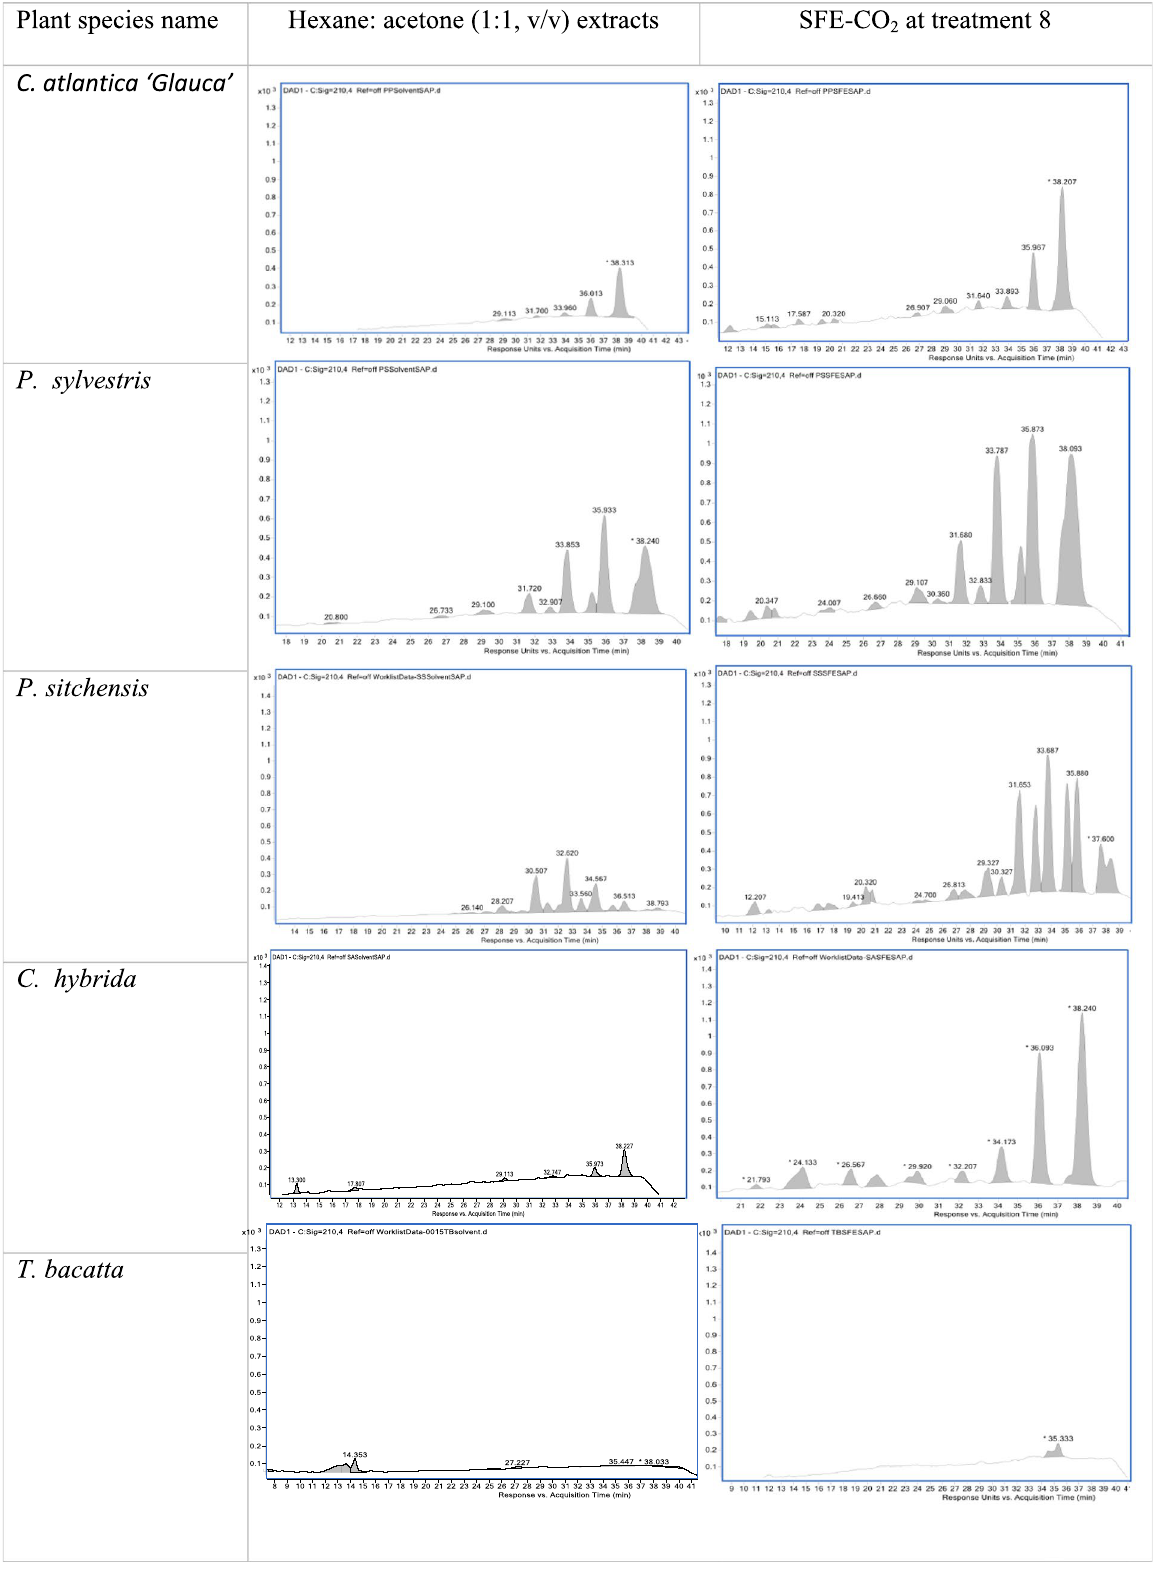
Table 3. Chromatograms of plant tissue extracted with hexane:acetone (1:1, v/v) solvent mix and SFE-CO 2 at ◦ C 200 bar, 70 , 7 h and 100% ethanol as a